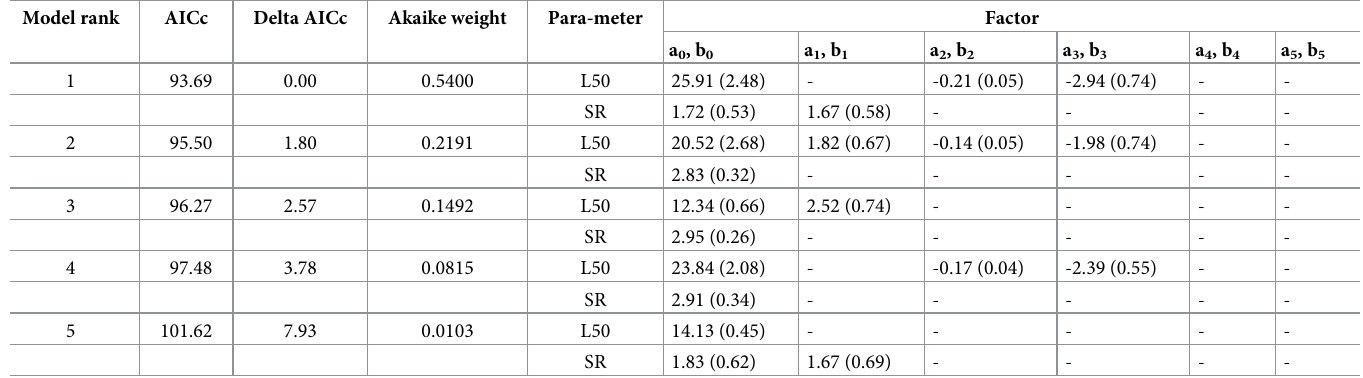
Table 3. Description and model ranking based on the full model (Eq 2) for Atlantic horse